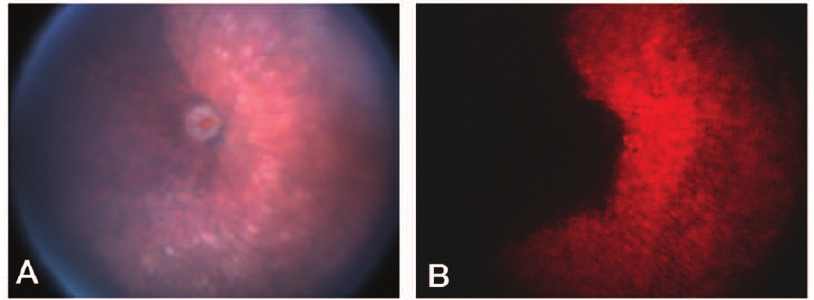
Figure 5. Extent of retinal transduction with AAV-VMD2- SOD2 Rz. Digital fundus images were made 4 months following subretinal injection of the AAV-VMD2- SOD2 Rz, which also contained the mCherry gene as a marker of genetic transduction. As previously reported [15] we routinely observe 60–80% transduction of the RPE. This was revealed as red-fluorescence using a long wave length filter (A) and as thinning of the retina (hypopigmentation) as a consequence of knockdown of MnSOD